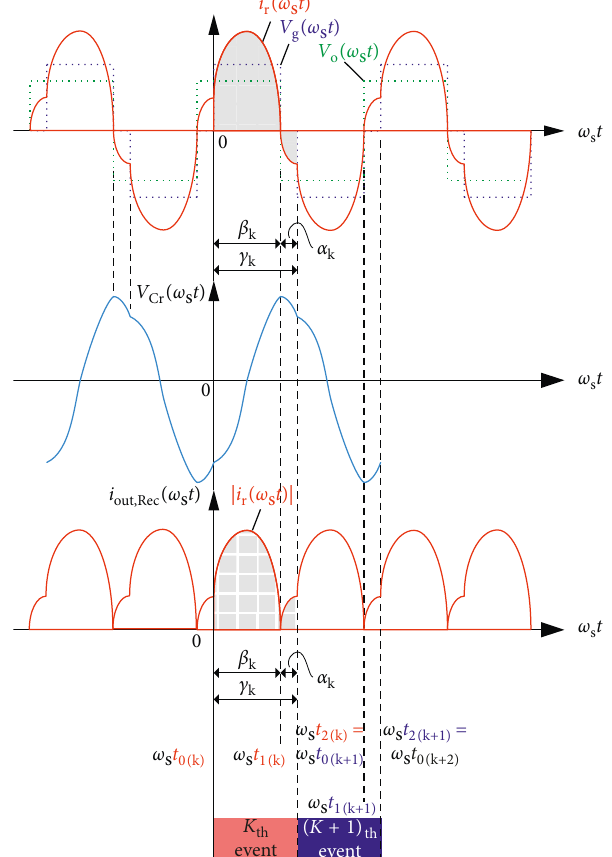
Figure 19: Resonant inductor current and resonant capacitor voltage waveforms of SRC# in subresonant CCM.